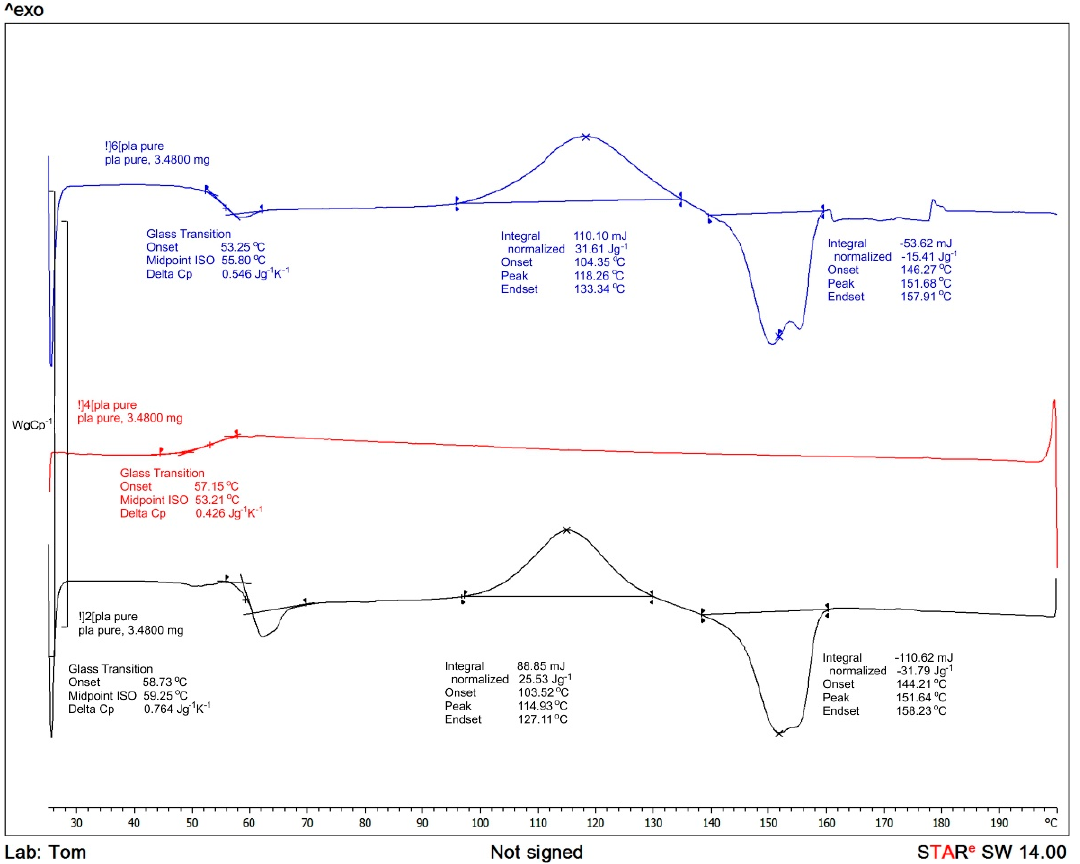
Figure 4. Thermal curves of compact PLA.